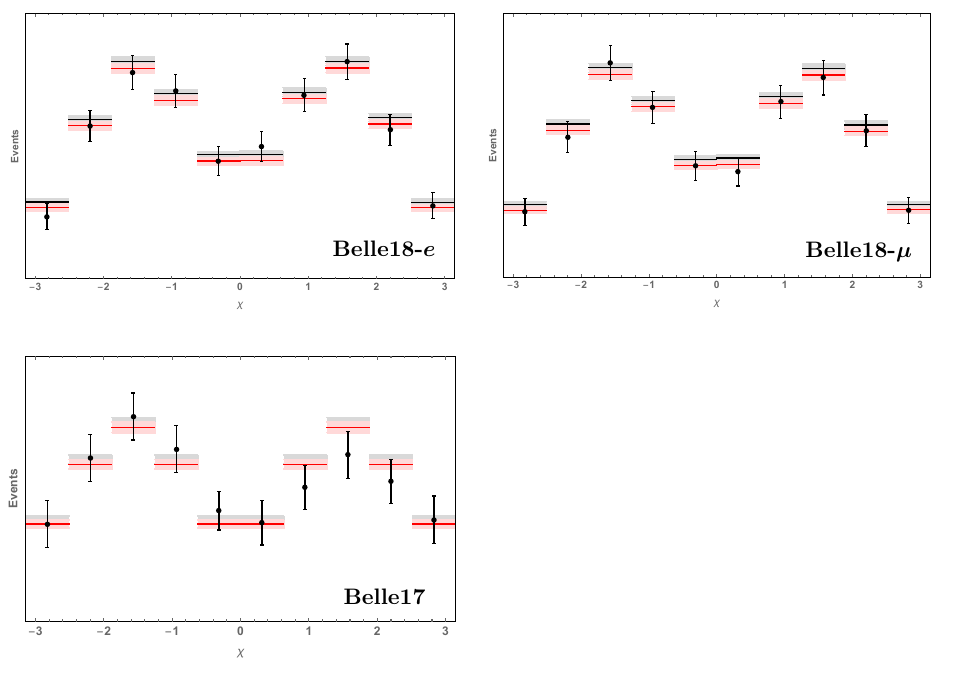
Figure 6 . Binned decay distributions of (cid:31) . Conventions are the same as in (cid:12)gure 3.